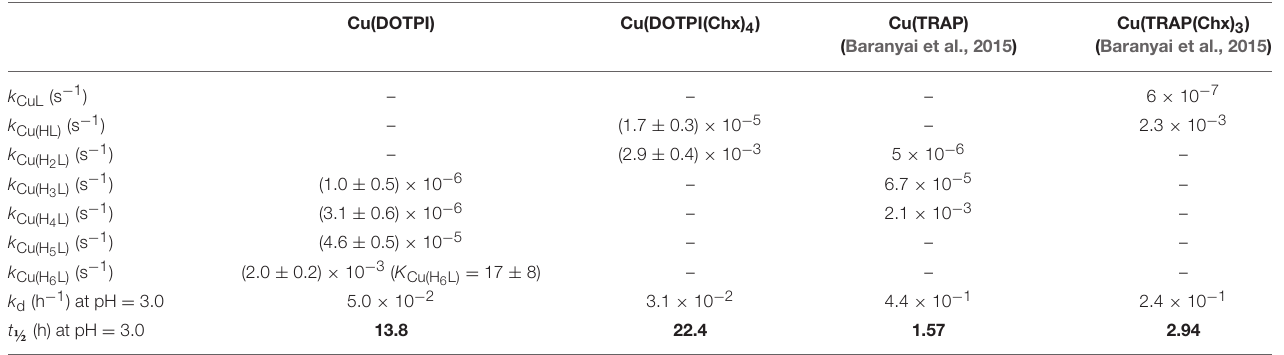
TABLE 3 | Rate constants ( k Cu(HiL) ) and half-lives ( t ½ = ln2/ k d ) characterizing the dissociation reactions of Cu(DOTPI) and Cu(DOTPI(Chx) 4 ) complexes (0.15M NaCl, 25 ◦ C). Cu(DOTPI)